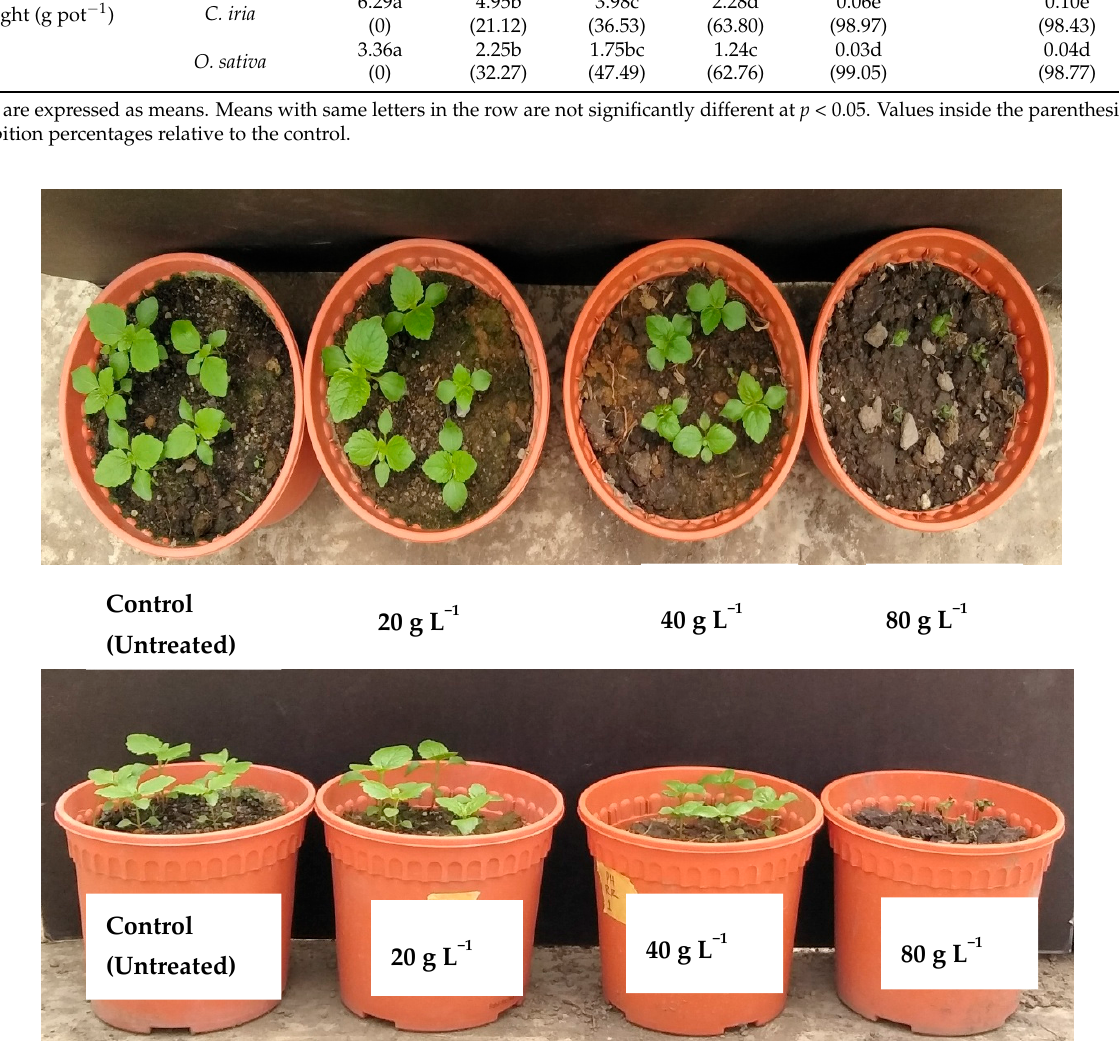
Figure 4. Effect of P. hysterophorus extract at 80 g L − 1 concentration on A. conyzoides at 24 h after spray compared with glufosinate-ammonium and glyphosate herbicides. 3. Discussion The allelopathic potential of P. hysterophorus on C. iria was studied in this study. The methanol extract of P. hysterophorus influenced C. iria seedling growth and germination percentages. The extracts had a dose-dependent effect on the germination percentage, col- eoptile and radicle growth of the tested weed. Plant extracts are hypothesized to impede